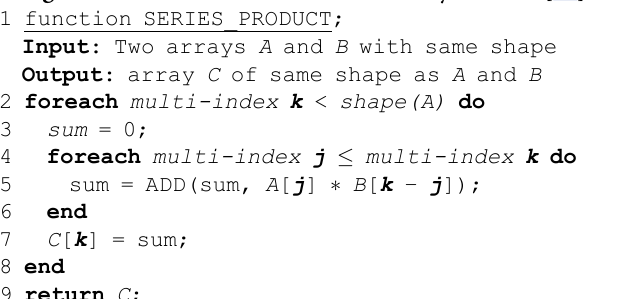
Algorithm 2 : Product of two truncated Taylor series